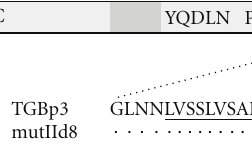
Figure 2: Schematic representation of TGBp3 mutant 18KmutIId8. The box represents TGBp3 sequence. Hydrophobic sequence seg- ments are shown as dark grey boxes. Conserved amino acid motifs are indicated. Sequences of the C-terminal hydrophobic segment in the wild-type protein and 18KmutIId8 are shown below the protein scheme. Hydrophobic regions are underlined; the positively charged Lys residues are shown in bold. Dots show identical residues, and dashes indicate